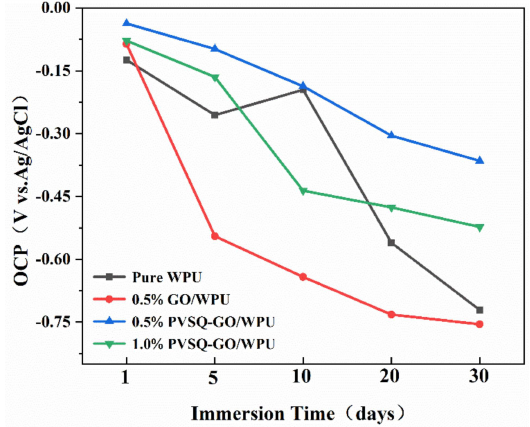
Figure 9. Evolution of open circuit potential (OCP) value for the coating specimens with continuous